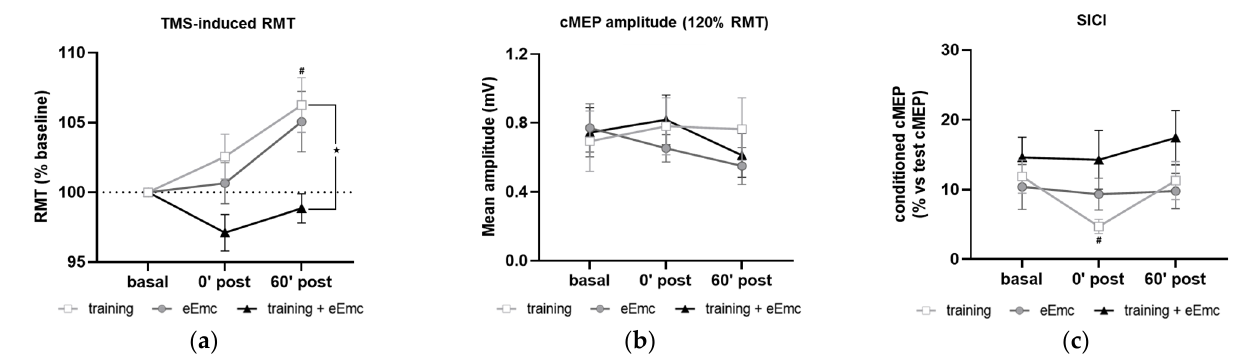
Figure 5. Effect of hand training, eEmc and eEmc + training on the corticospinal excitability and SICI. ( a ) Percentage of resting motor threshold (RMT) vs. baseline levels in APB at 0 min (0 (cid:48) post) and 60 (cid:48) min (60 (cid:48) post) after intervention. Significant differences between interventions: (cid:70) p < 0.05, (training vs. eEmc + training), and in comparison to baseline: # p < 0.05 (for training). ( b ) Effect of training, eEmc and eEmc + training on the supramaximal cMEP amplitude (120% transcranial magnetic stimulation (TMS)) according to RMT. ( c ) SICI: (average of conditioned cMEP) × 100/ (average of test cMEP) recorded at APB muscle and obtained at 0 (cid:48) and 60 (cid:48) after each intervention. # p < 0.05 for training at 0 (cid:48) post in comparison to baseline. APB, abductor pollicis brevis; RMT, resting motor threshold; cMEP, cortically-induced motor evoked potential; SICI, short-interval intracortical inhibition.